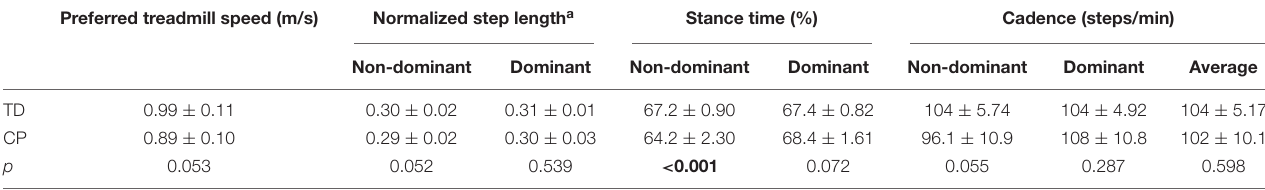
TABLE 2 | Spatiotemporal metrics during treadmill walking. Preferred treadmill speed (m/s) Normalized step length a Stance time